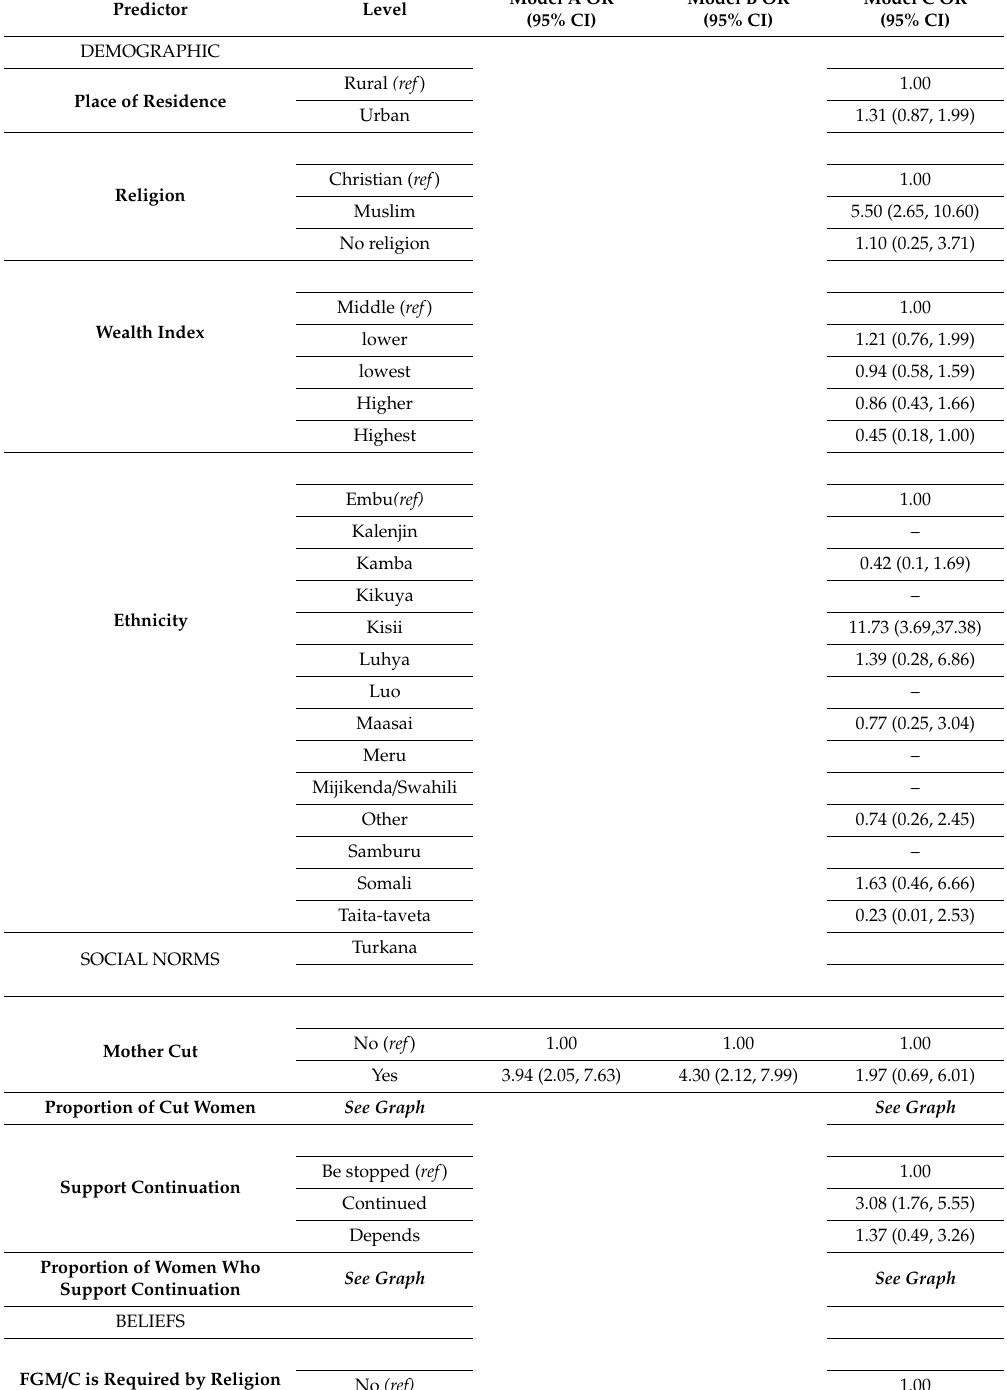
Table A2. Unadjusted and adjusted posterior odds ratios (POR) and associated 95% credible regions of circumcision of Girls ages 0–14 across selected covariates (Kenya, DHS 2014) from Bayesian Geo-additive